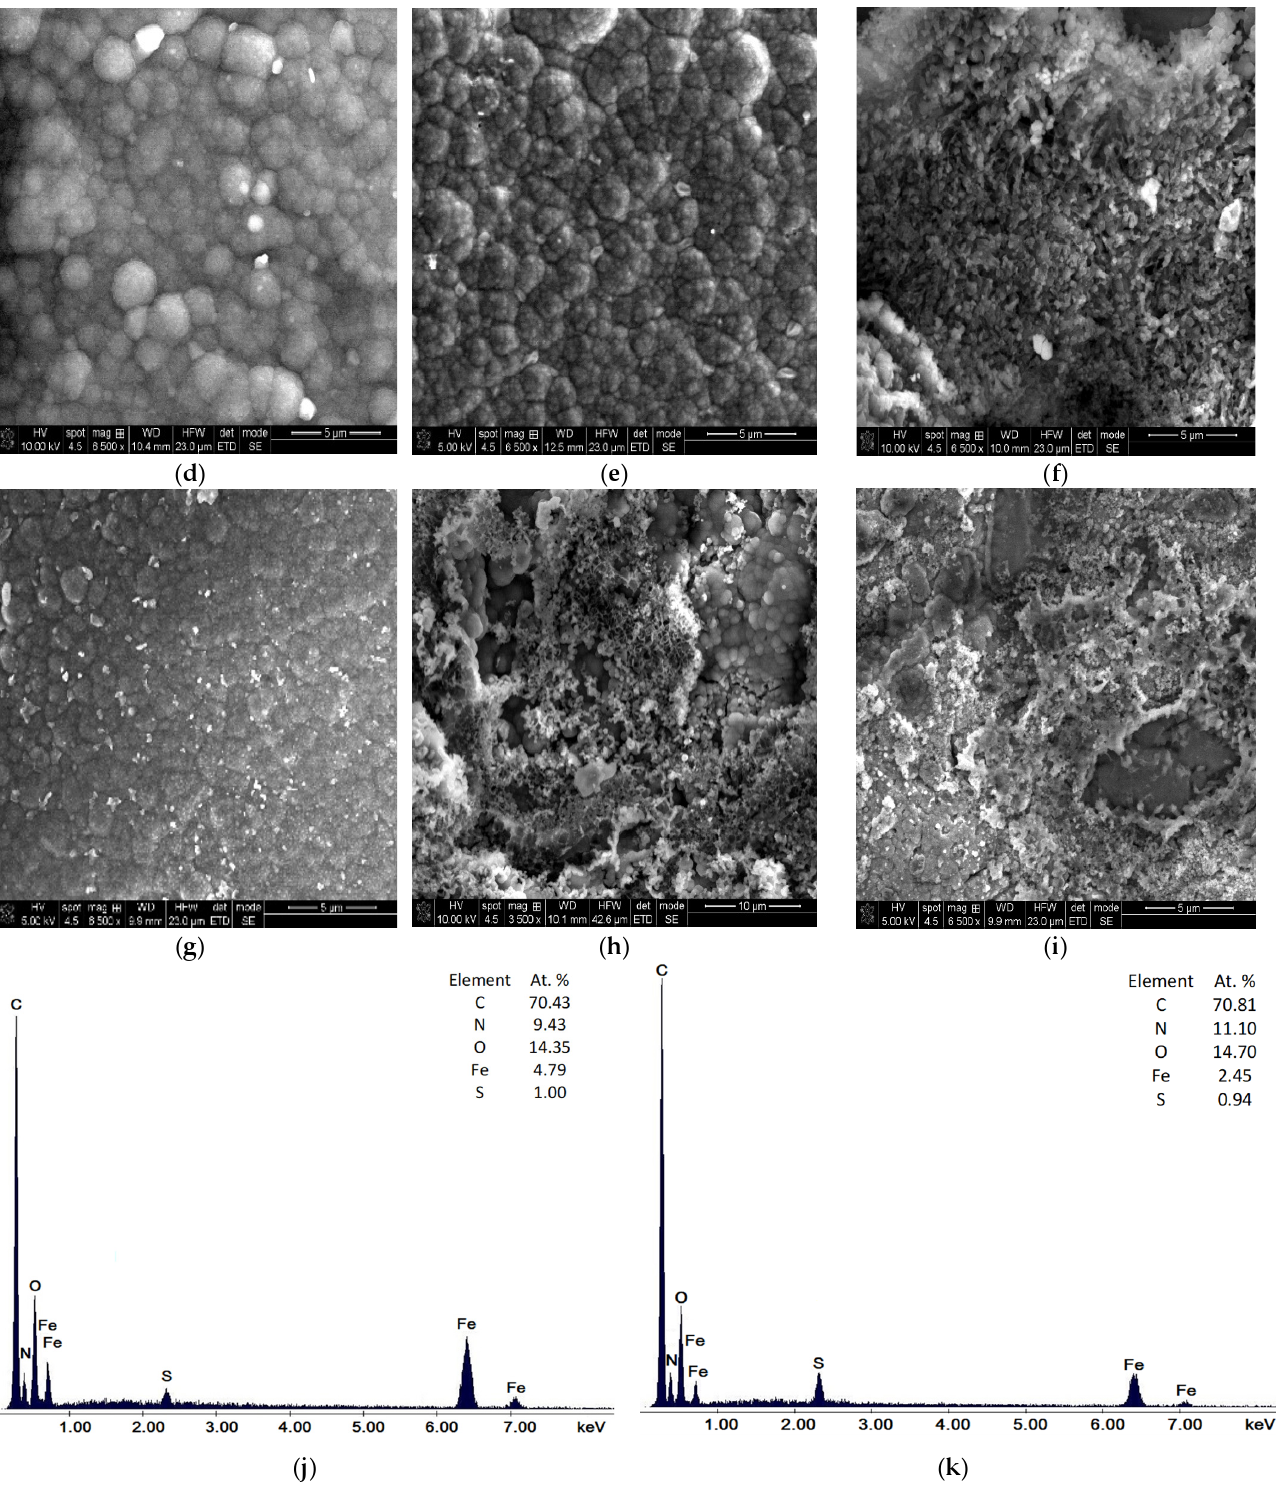
Figure 11. SEM micrographs of OLC 45 electrode coated with PNMPY-TW20/P3MT/OLC 45, ( a , b ) at 3 mA/cm 2 , ( c , d ) 5 mA/cm 2 with 5:1, 3:5 molar ratio, ( e ) 1.2 V and ( f ) 1.4V and ( g – i ) after 96 h, 120 h and 168 h immersion time in 0.5 M H 2 SO 4